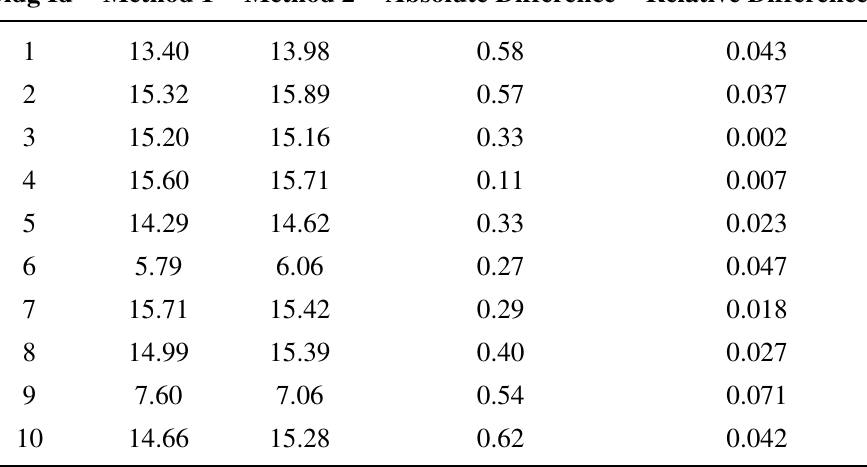
Table 3. Comparison of building height estimates with the French IGN Batimap